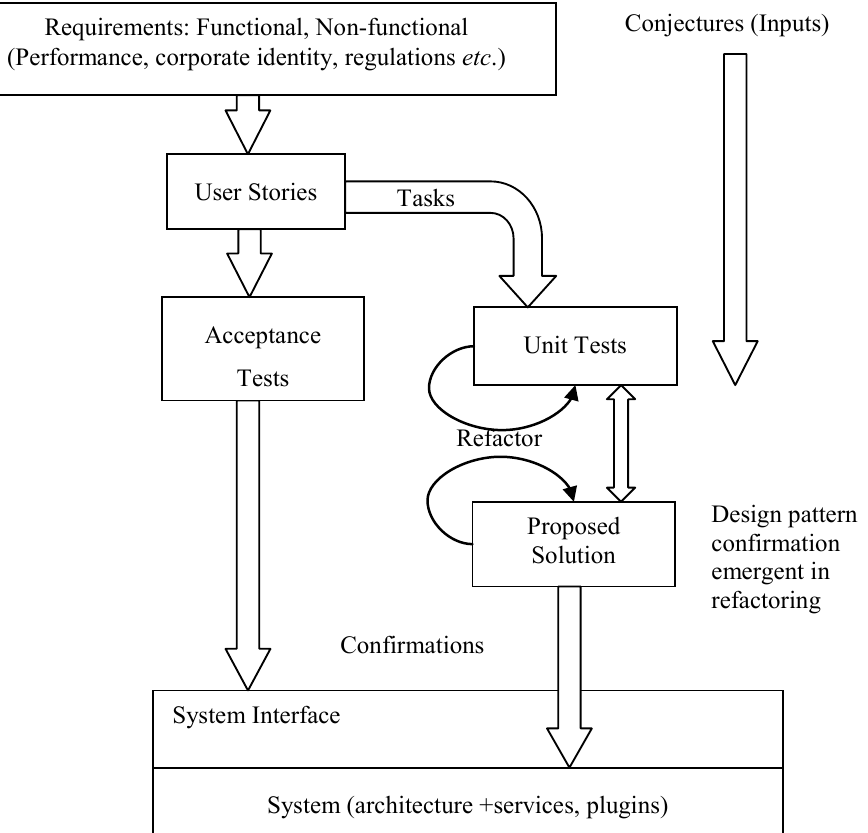
Figure 4. Conjecture and confirmation in an agile